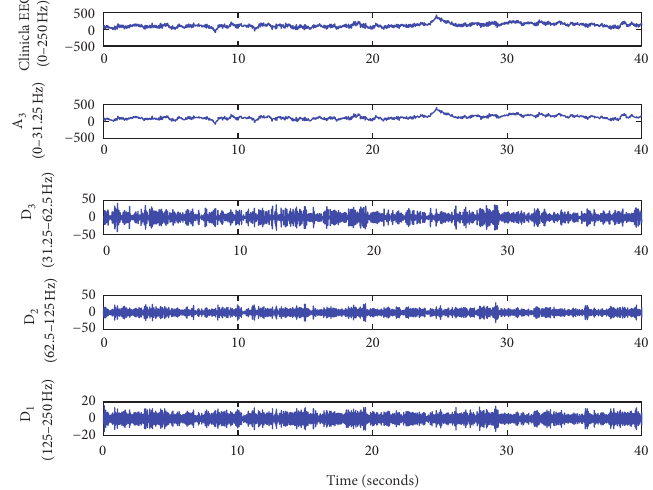
Figure 4: Applied three-level DWT of a clinical EEG